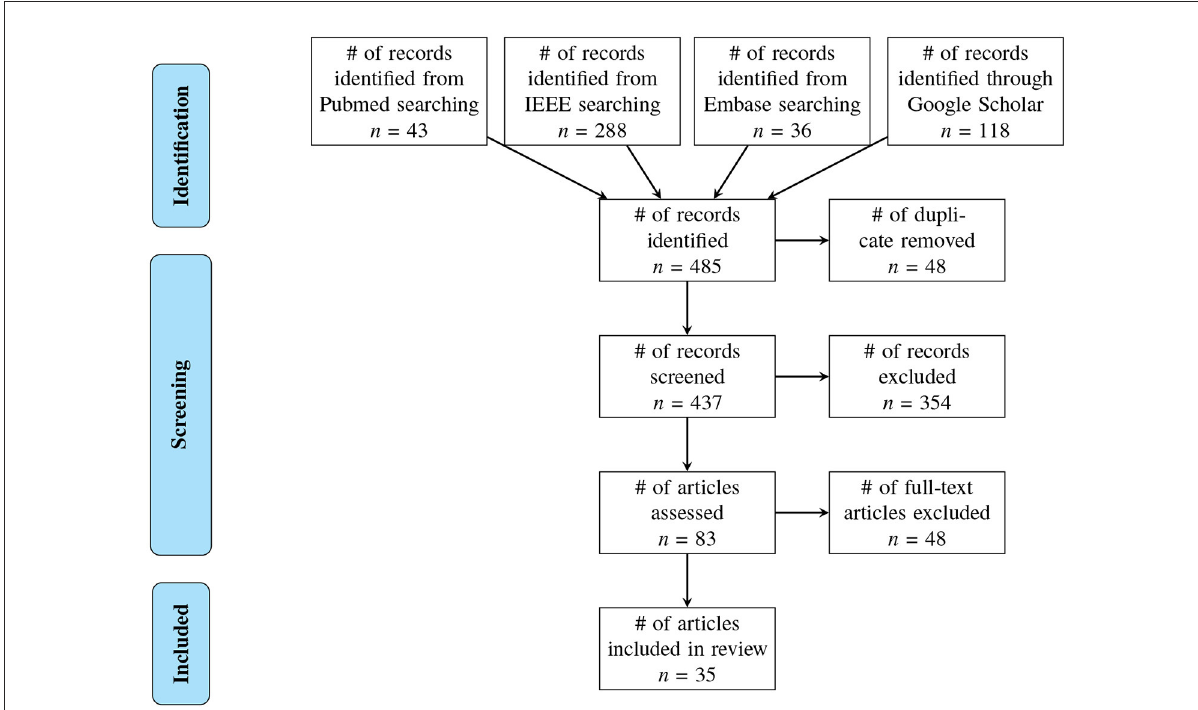
FIGURE1 Flow chart of the methodology used to screen the articles. Thirty-five articles published between 2008 and 2021 were included in the